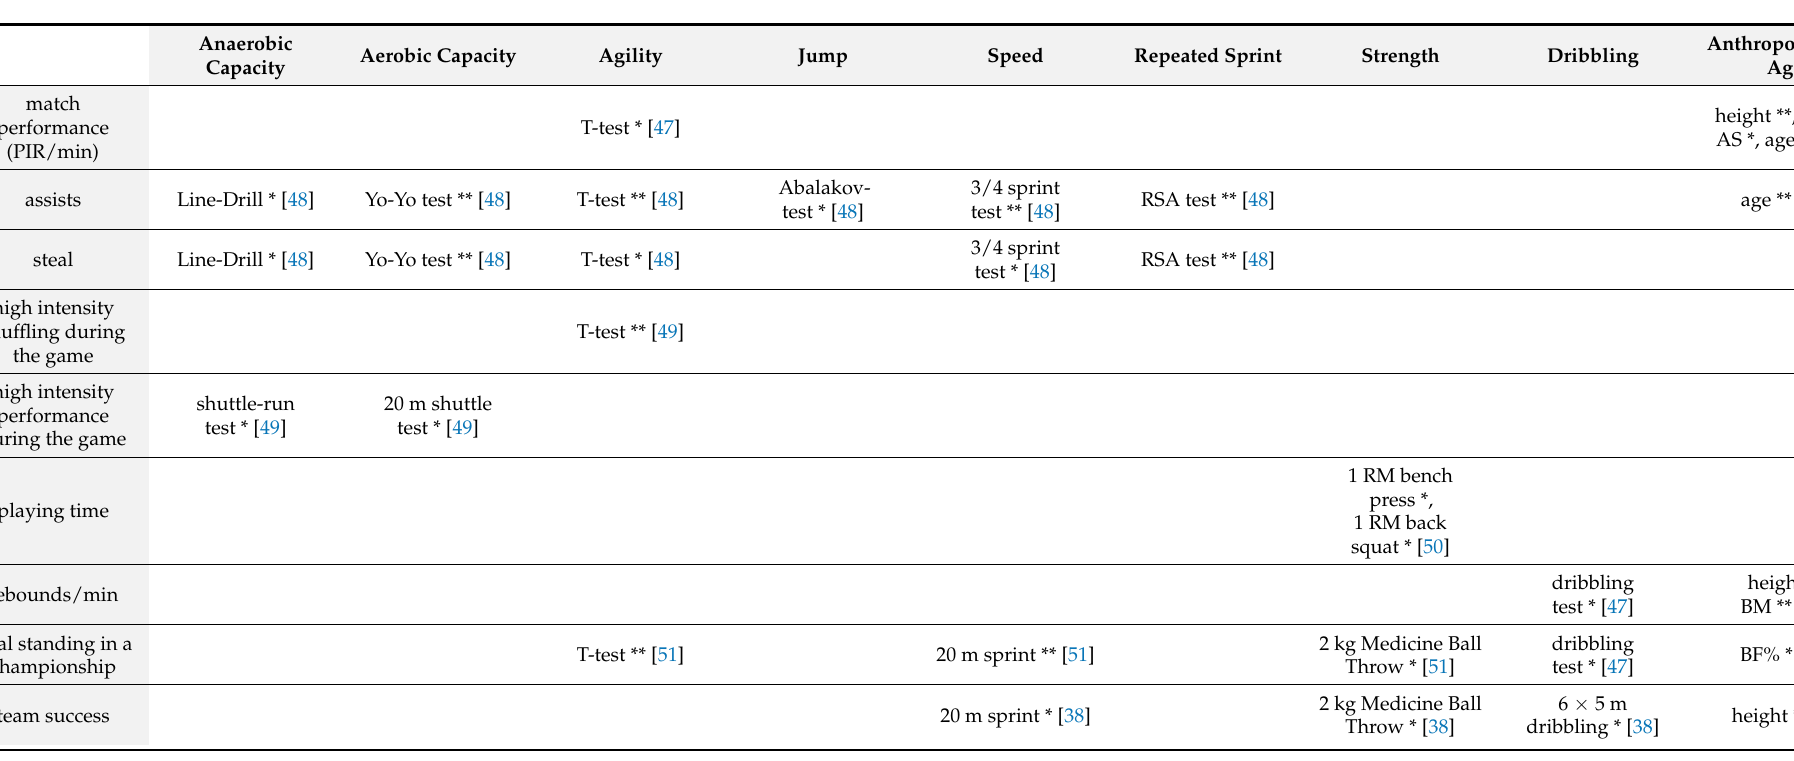
Table 3. Correlations between test results of skills and match